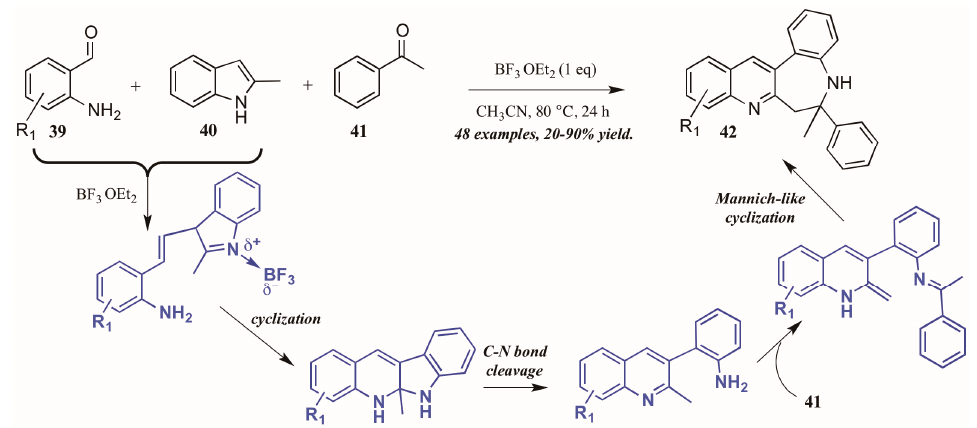
Figure 19. Lewis acid-catalyzed Friedländer quinoline synthesis.